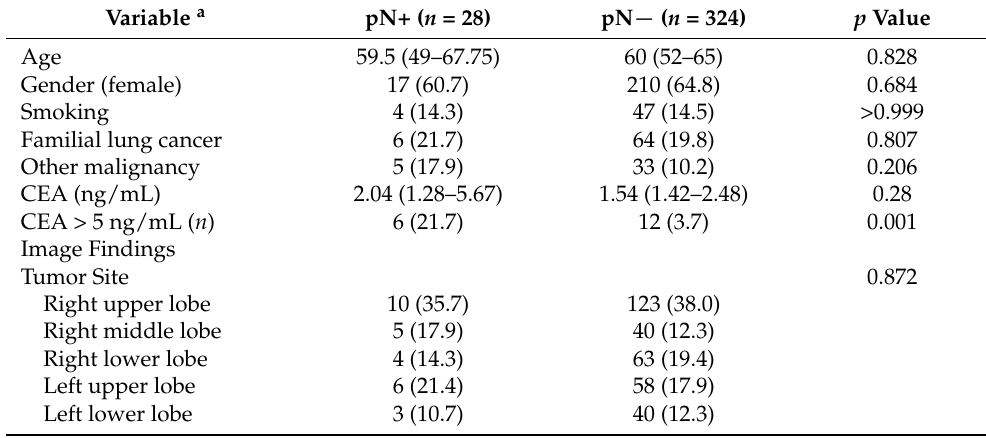
Table 1. Results between patients of adenocarcinoma with and without lymph nodal